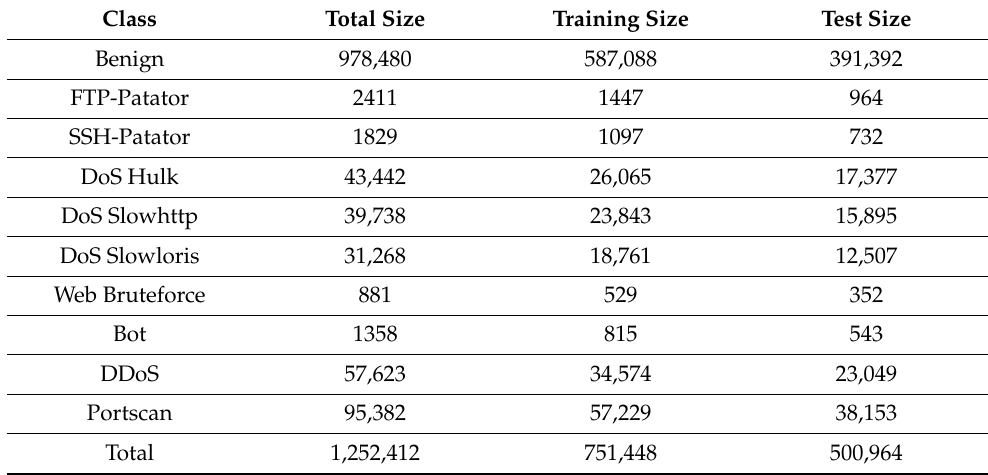
Table 7. Dataset size of CIC-IDS2017.